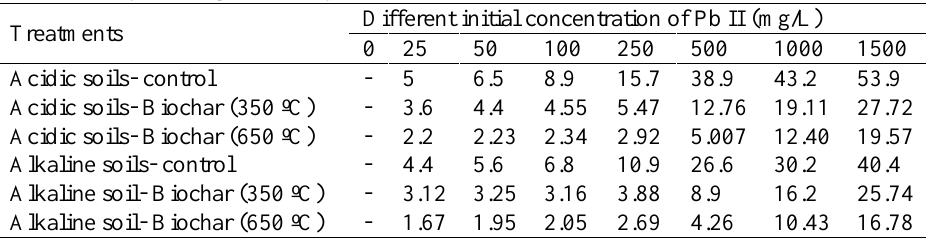
Table 8. The percentage of desorption Pb (II) from two soils